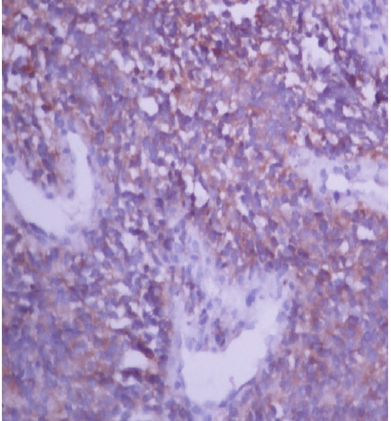
Figure 5: The figure shows BCL2